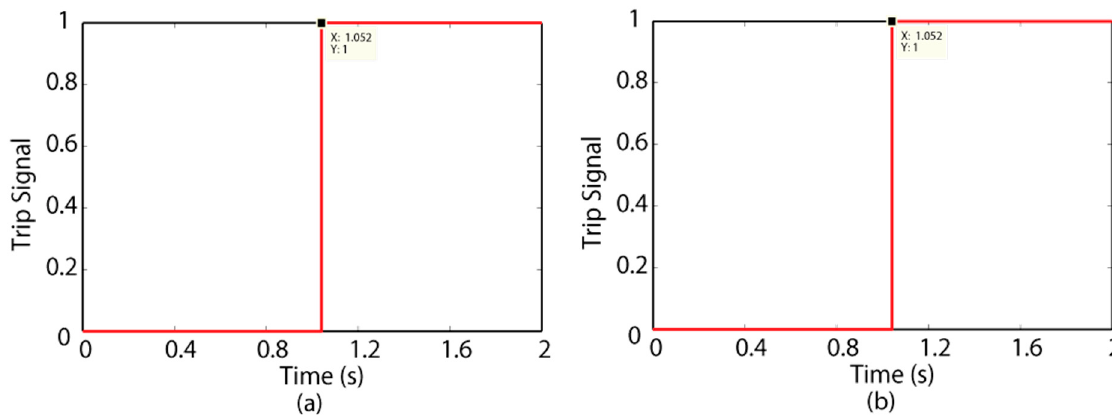
Figure 17. Breaker status for ( a ) CB8 and ( b ) CB9 during fault.